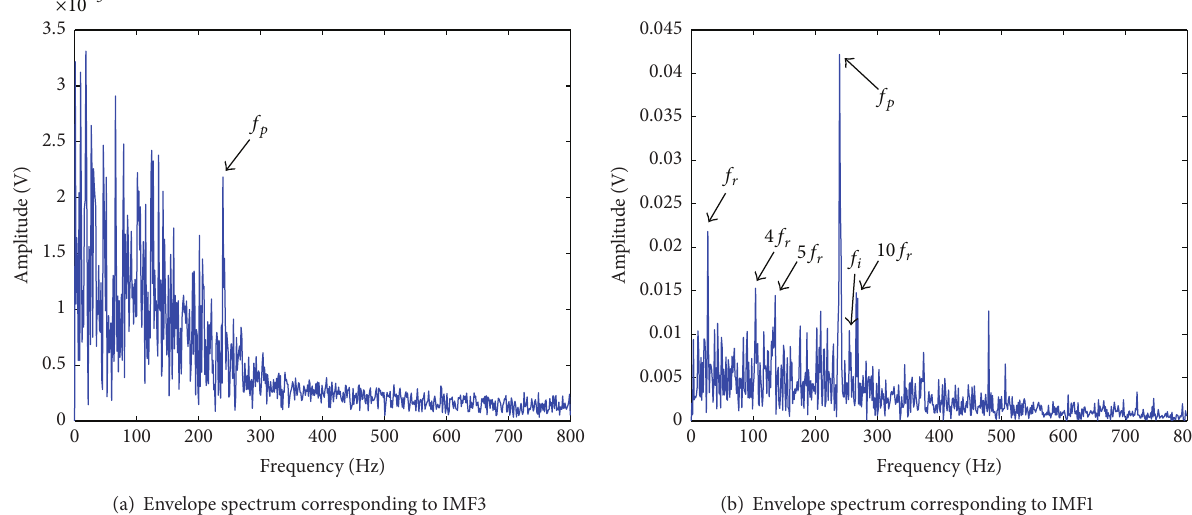
Figure 6: Bearing compound fault diagnosis by traditional